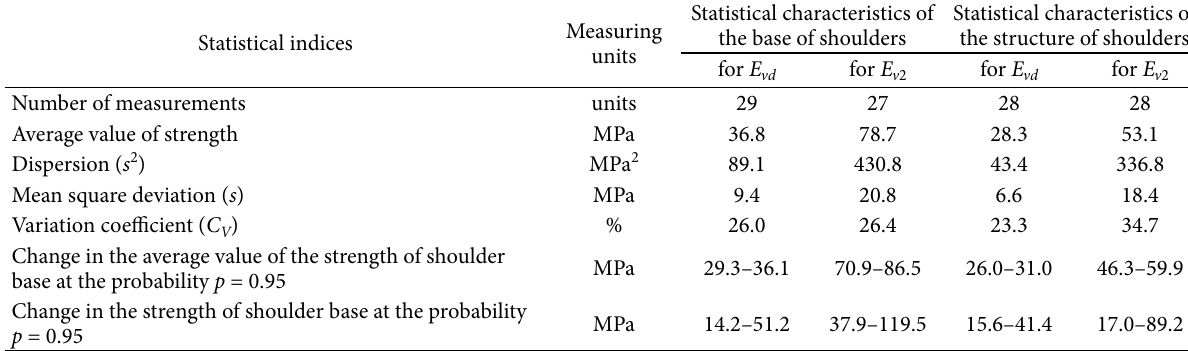
Table 2. Statistical characteristics for the strength of shoulder base and the shoulder structure ( E vd ir E v 2 ) on regional roads Statistical